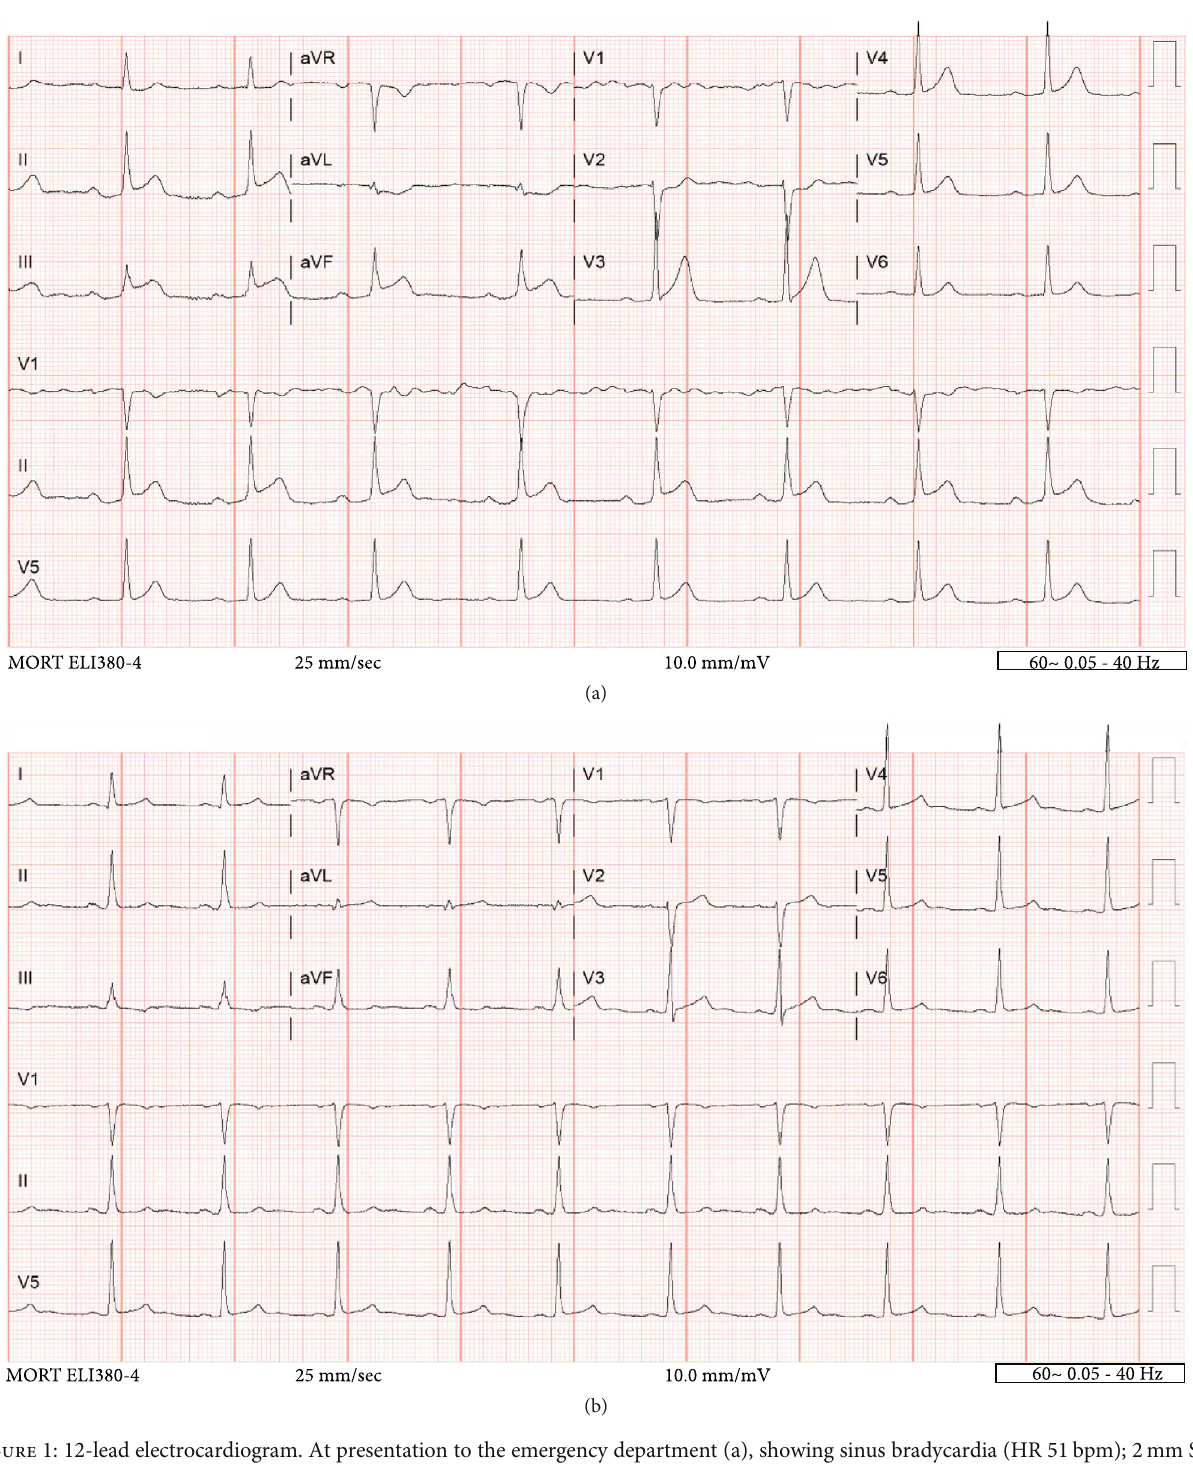
Figure 1: 12-lead electrocardiogram. At presentation to the emergency department (a), showing sinus bradycardia (HR 51 bpm); 2mm ST- segment elevations in leads II, III, and aVF with reciprocal depression in aVL; and fi rst-degree AV block (PR 200ms). Approximately one hour later (b), there is resolution of ST-segment changes in leads II, III, and aVF as well as resolution of fi rst-degree AV block (PR 179